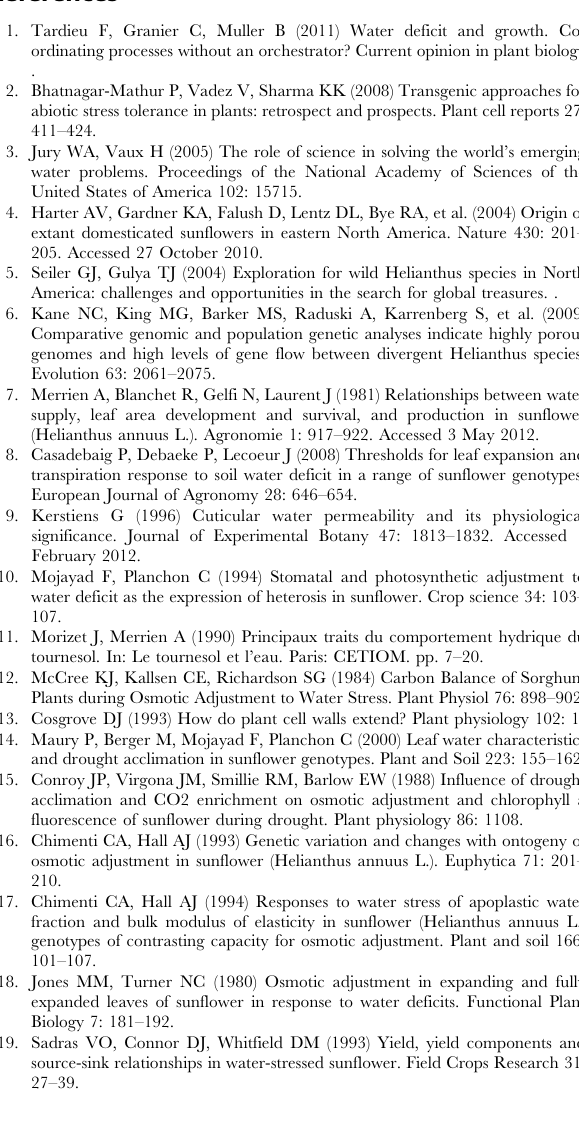
Figure S5 Scatter plots and correlations between the Affymetrix microarray intensities and the q-RTPCR results. Genotypes are color-coded as follows: Inedi (black), Tekny (gray), Melody (red), SF109 (turquoise), SF326 (yellow), SF193 (magenta), SF028 (green) and SF107 (blue). Table S1 Phenotypic data of each sunflower plant in FDS and FIS in greenhouse experiment. Table S2 Sunflower Affymetrix probeset annotations and statistical test results for the ANOVA analysis in FDS and FIS. Table S3 Numbers of transcripts associated to the different phenotypic varibles in the Gene-Phenotype network obtained through the sPLS analysis. Table S4 Sunflower Affymetrix probesets regulated by drought stress in field condition and their annotations,